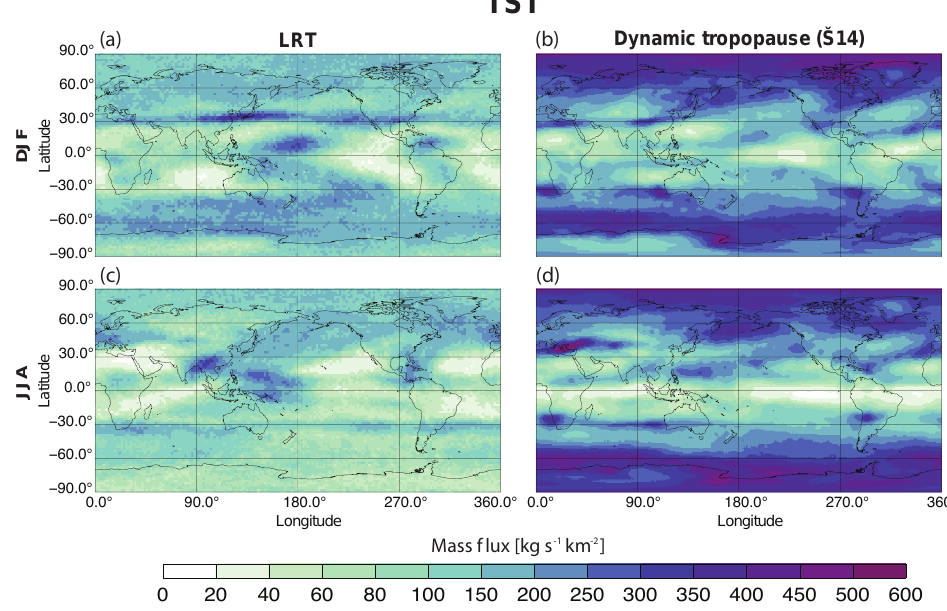
Figure 3. The same as in Fig. 2 but for TST.